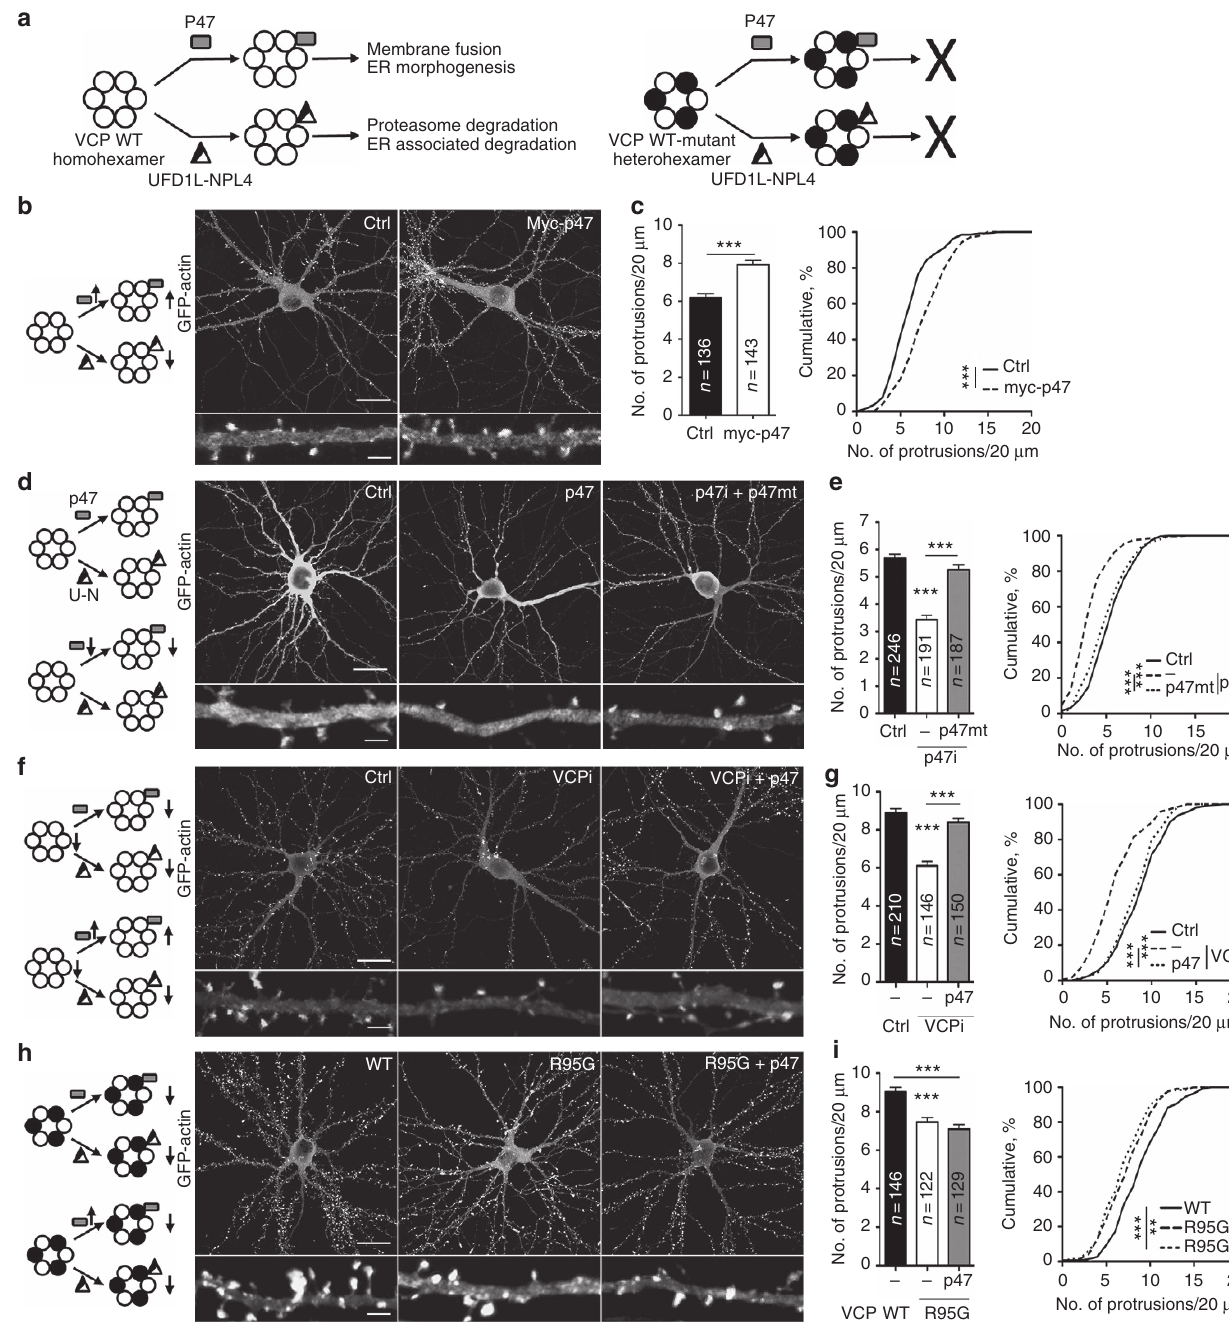
Figure 1 | P47 acts downstream of VCP to regulate dendritic spine formation. ( a ) A schematic of VCP hexamers and their cofactors, P47 and the UFDL1-NPL4 dimer, in two distinct functions. Heterohexamers containing WT (open circle) and mutant (closed circle) VCP are inactive. ( b , d , f , h ) Cultured neurons were cotransfected with GFP-actin and the indicated plasmids at 12 days in vitro (DIV) and fixed for dendritic spine analysis at 18 DIV. The expression of the various constructs was monitored by immunofluorescence staining, though only the GFP signals are shown to reveal the neuronal morphology. The left panels illustrate the experimental design and the predicted activity of the VCP complexes. Arrows pointing up or down indicate either the changes in the protein levels or the activities of the complexes. In the images, the lower panel enlargements are the quantitated segments from the upper panels. ( c , e , g , i ) Quantitation of the protrusion densities collected from three independent experiments. The means plus s.e.m. and the cumulative probability are shown. The sample sizes ( n ) of the analyzed dendrites are indicated. Ctrl, non-silencing control. Scale bars: original, 20 m m; enlarged, 2 m